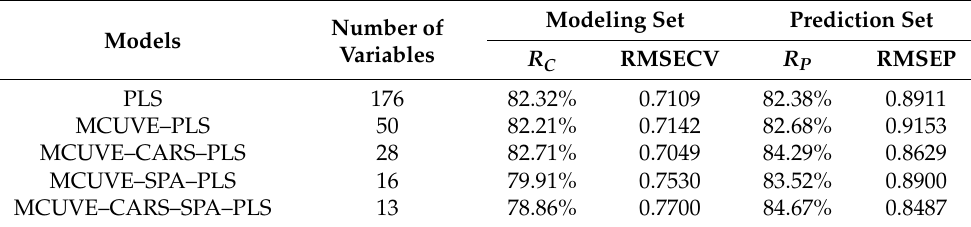
Table 4. PLS modeling results based on different combinations of wavelength selection